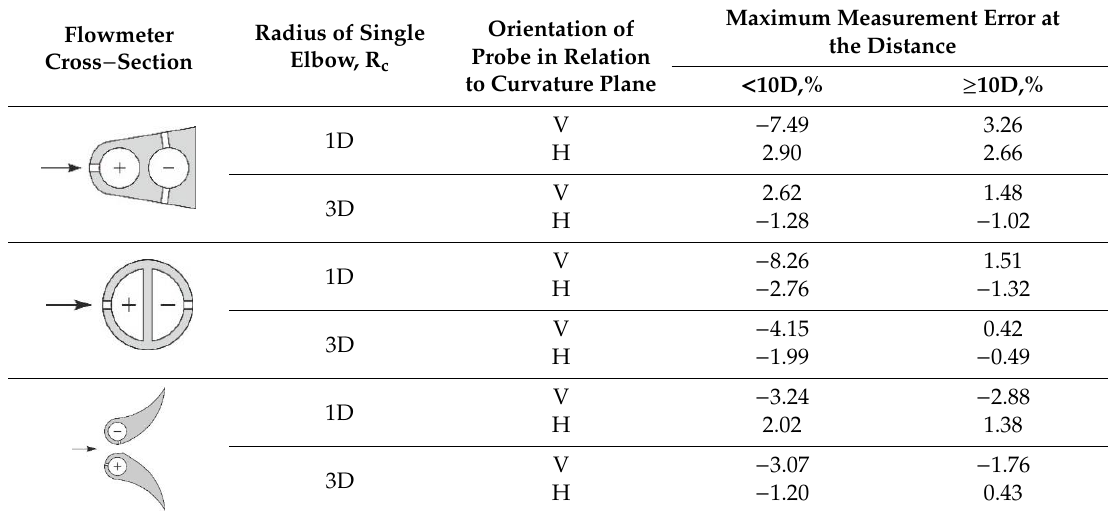
Table 2. Maximum values of additional measurement error resulting from disturbance (single elbows of different radii) of the velocity profile ( V —vertical position, H —horizontal installation of the probe).